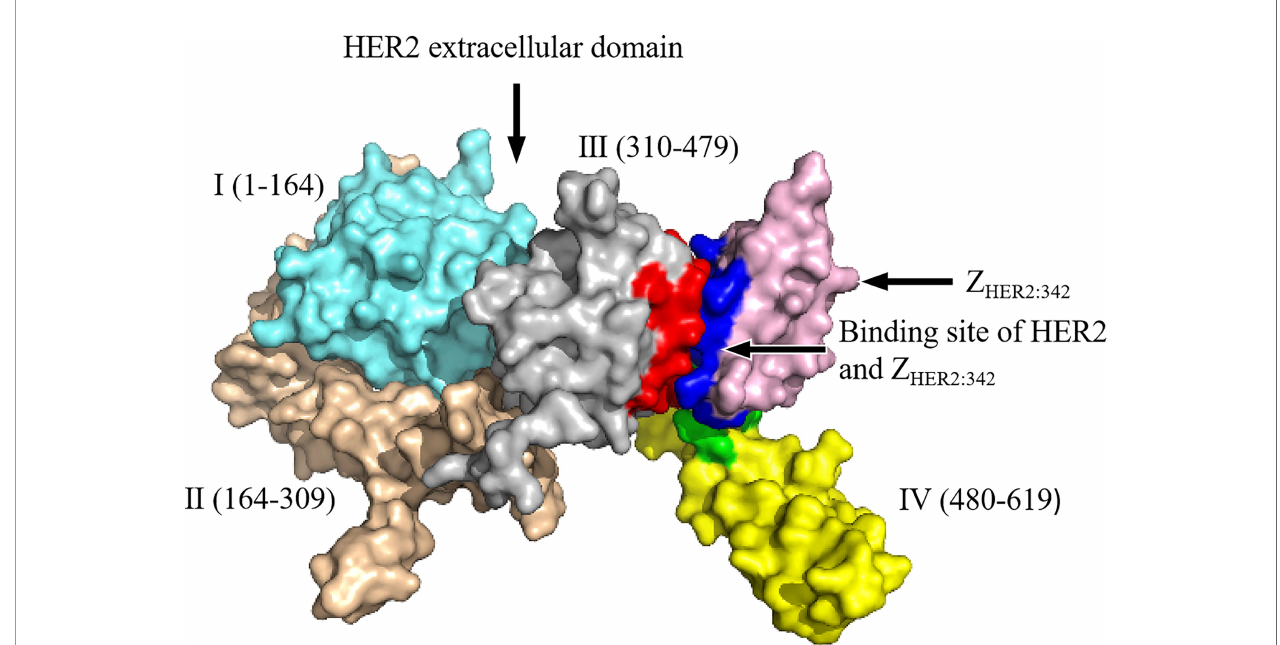
FIGURE 1 | The schematic representation of HER2 af fi body and the molecular interactions with its targets: the HER2 extracellular region is further divided into domain I (1 – 164, sky blue), domain II (164 – 309, brown), domain III (310 – 479, silver gray), and domain IV (480 – 619, yellow). Pink represents Z HER2:342 ; dark blue represents Z HER2:342 binding residues; red represents residues on domain III that interact with Z HER2:342 ; green represents residues on domain IV that interact with Z HER2:342 . The detailed amino acid sequences of HER2 extracellular domains I – IV are presented in Supplementary Table 1